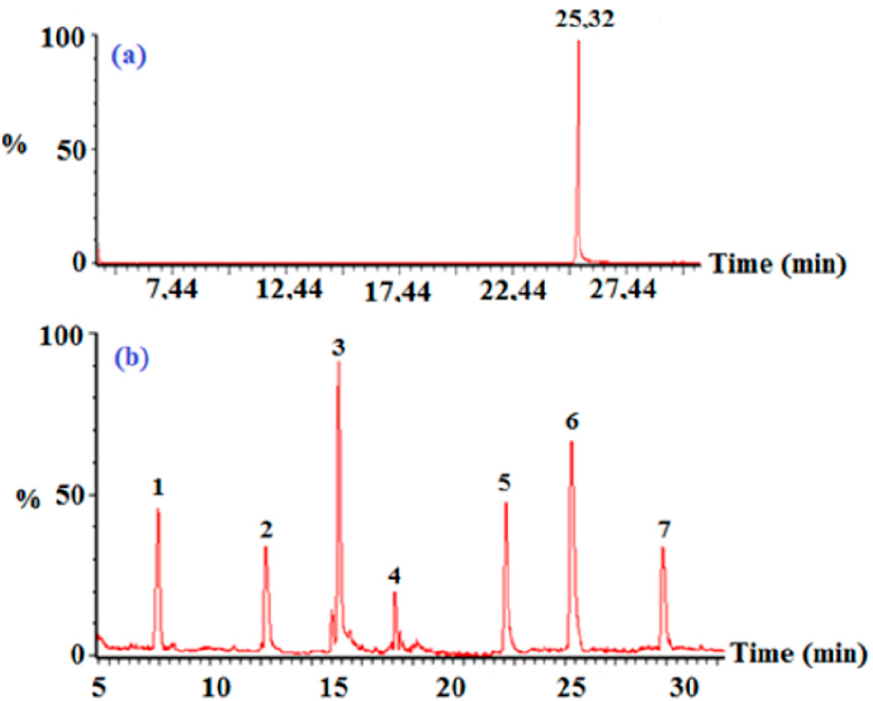
Figure 11. ( a ) Total ion chromatogram of 2,3,4,5-TeCP at t = 0; and ( b ) after 120 min illumination time: